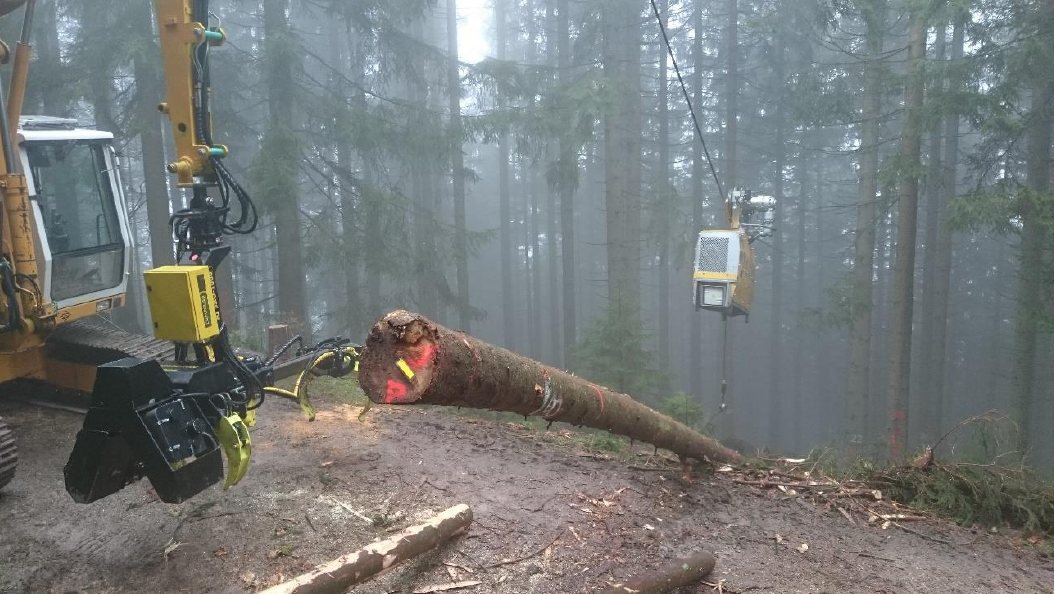
Figure 4. The intelligent carriage extracted and brought a tree to the excavator with an intelligent processor head in the landing area. RFID tag (yellow) visible on the bottom end of the tree.